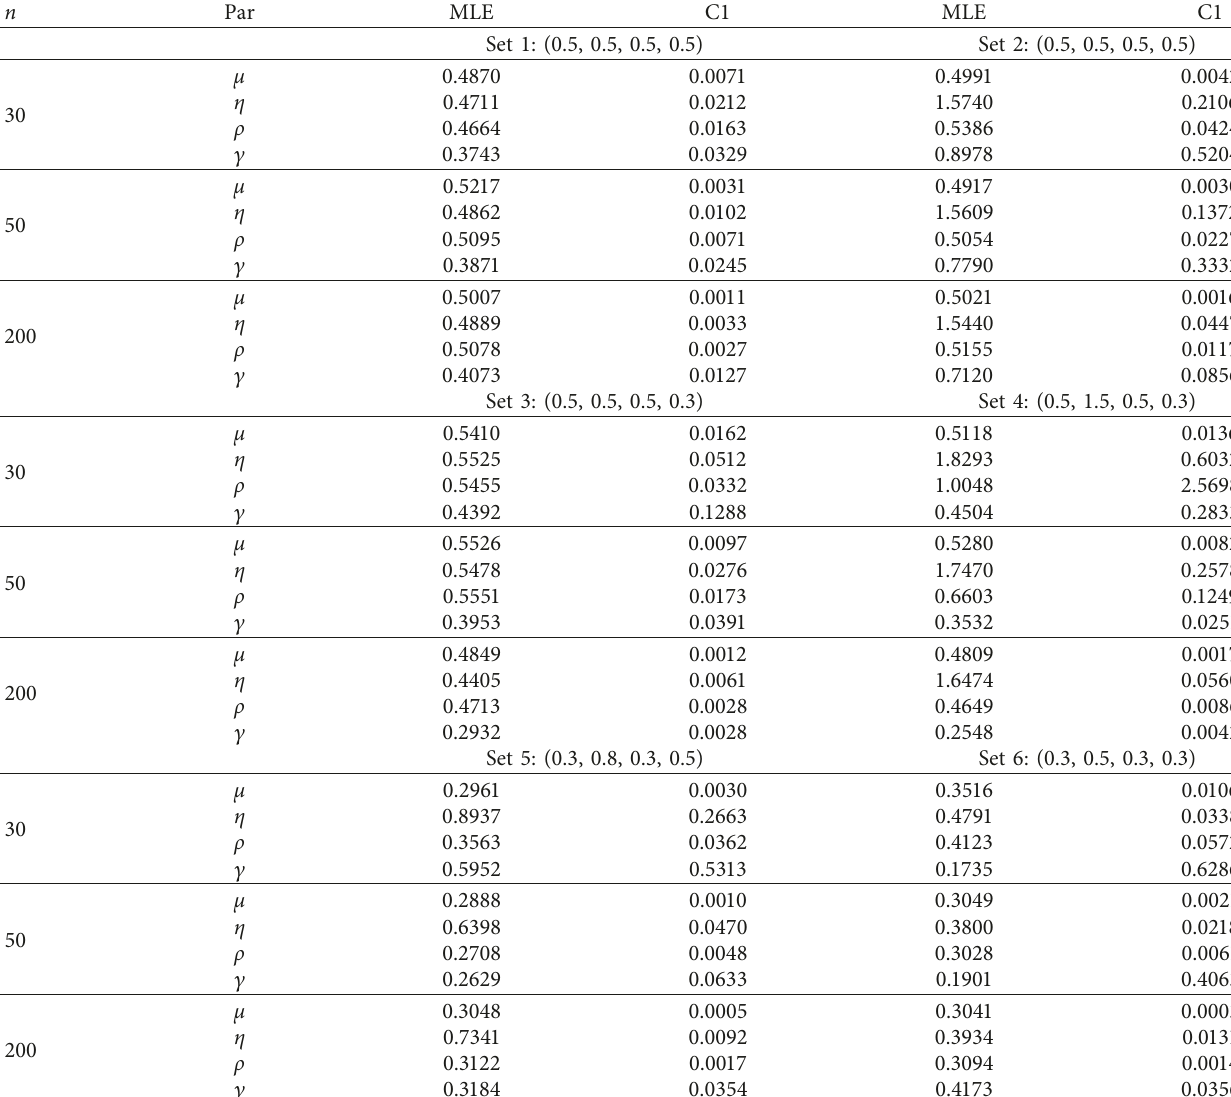
Table 2: Numerous numerical values of MLEs and C1 of the TIITLGINW